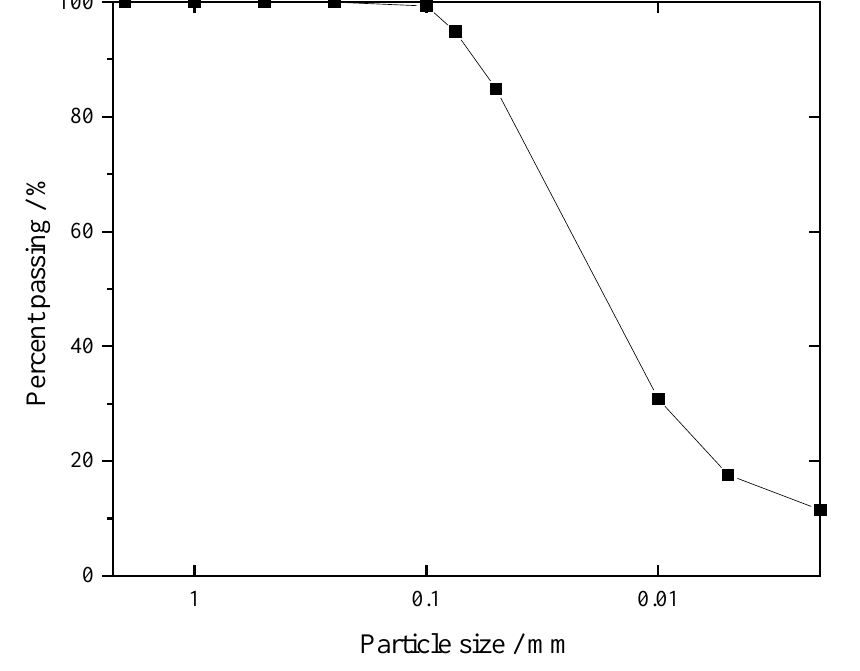
Figure 4. Particle size distribution curve of the loess. Table 1. Physical properties of the tested loess.